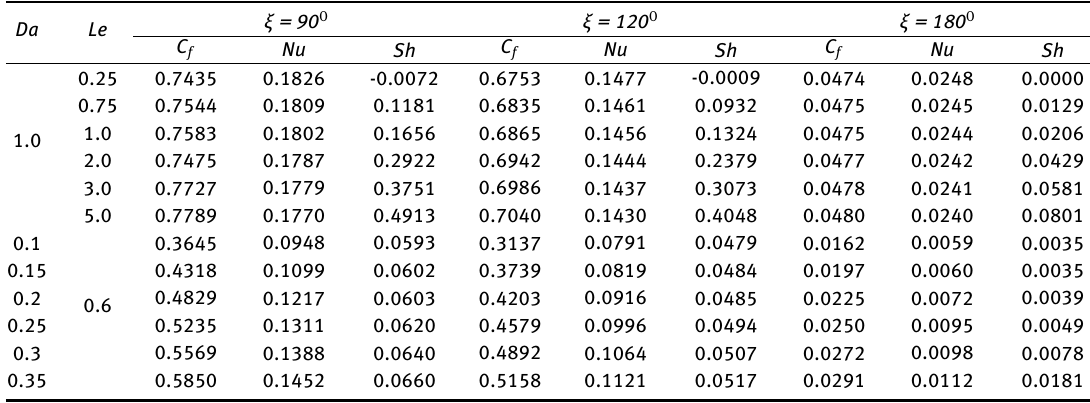
Table 5: Values of C f , Nu and Sh for different Da , Le and ξ ( β = 1.0, Nb = Nt = 0.2, Nt = 0.1, Λ = 1.0, M = 0.5, Pr =